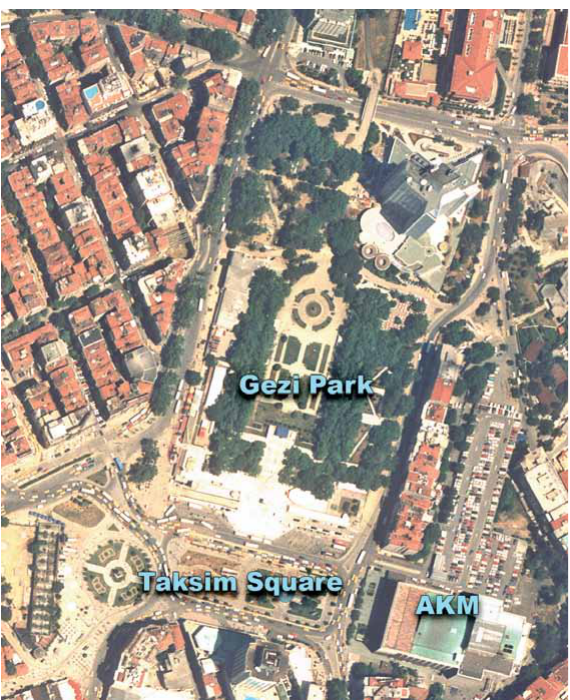
fig. 5. aerial photo of Taksim Square and Gezi Park before the pedestrianisation project, c. 2002. Istanbul